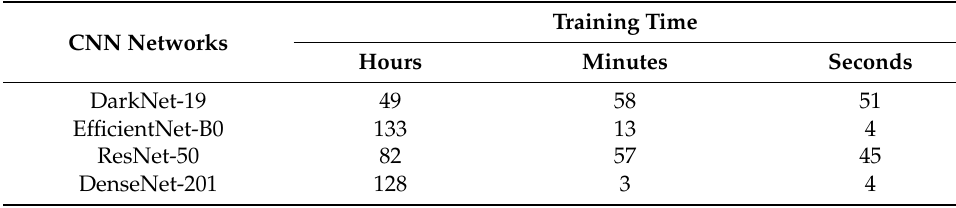
Table 1. Training time of four CNN